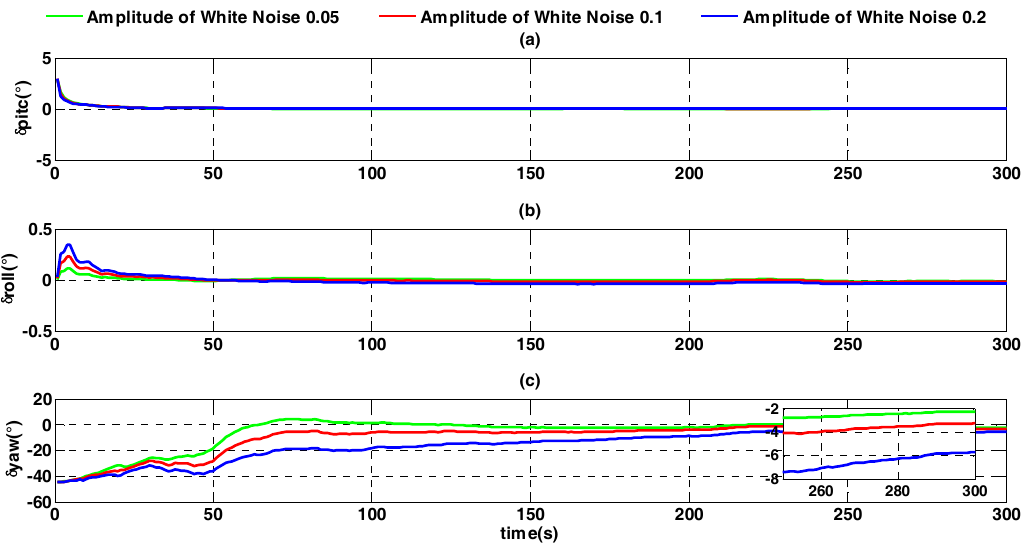
Figure 12. Alignment error curves with different random errors. ( a ) The error curves of pitch angle; ( b ) the error curves of roll angle; ( c ) the error curves of heading angle.